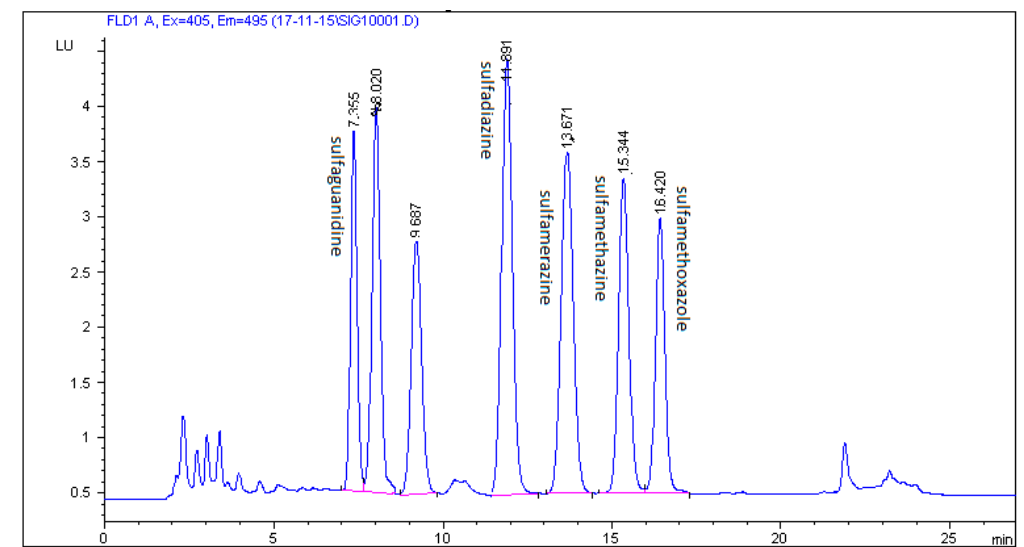
Figure 5. Chromatogram of feed sample spiked with five SAs at a concentration of 200 µg/kg on a Zorbax Eclipse XDB C18 column with a mobile phase of 0.1% acetic acid in Milli-Q water/acetonitrile/methanol.